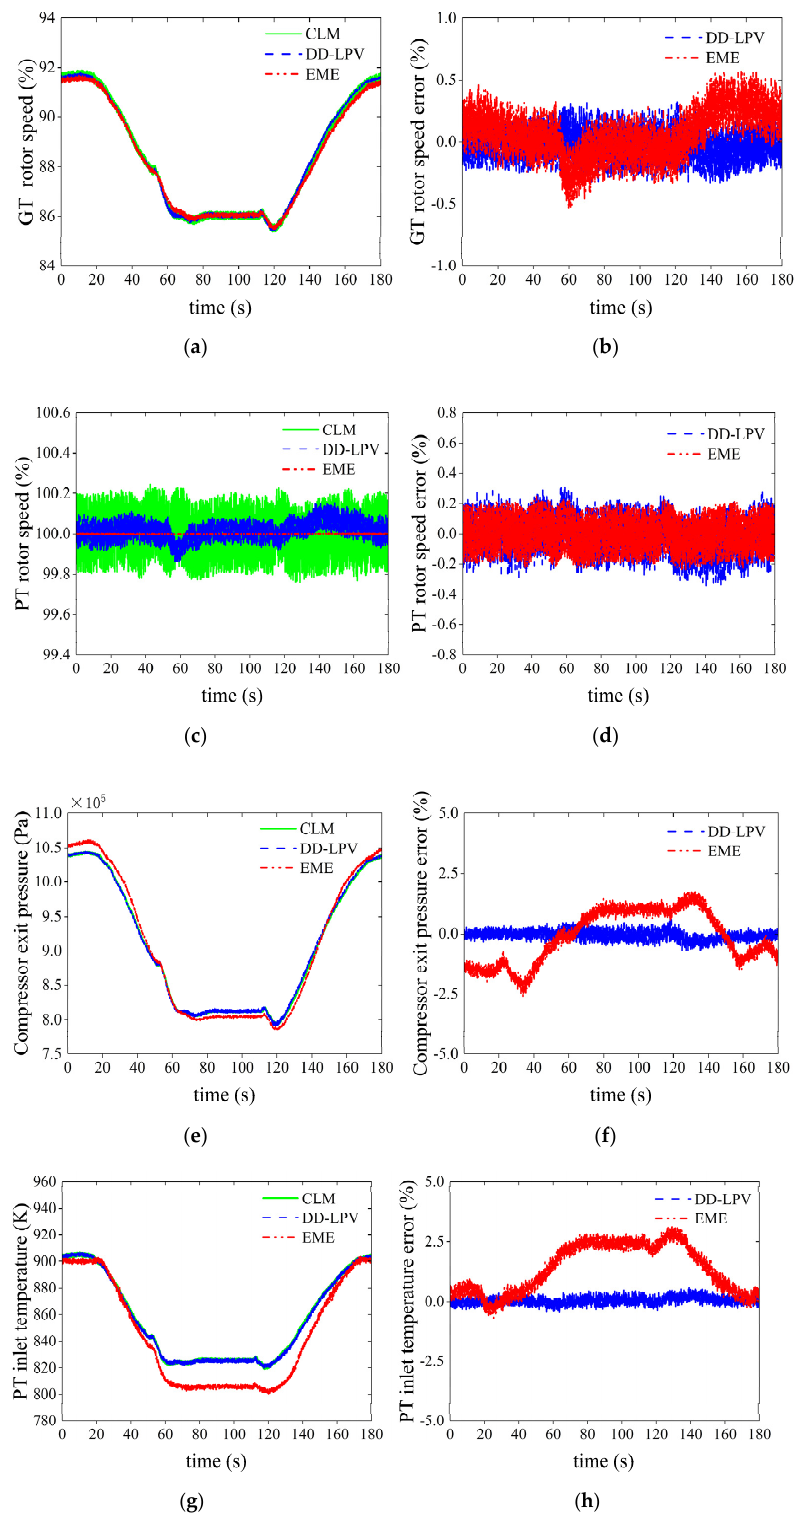
Figure 7. Prediction comparison of DD-LPV model and EME model to CLM at time k + 5, (at 3000 m, with measurement noise) ( a ) Prediction of GT rotor speed. ( b ) Relative error of GT rotor speed prediction. ( c ) Prediction of PT rotor speed. ( d ) Relative error of PT rotor speed prediction. ( e ) Prediction of compressor exit pressure. ( f ) Relative error of compressor exit pressure prediction. ( g ) Prediction of PT inlet temperature. ( h ) Relative error of PT inlet temperature prediction.